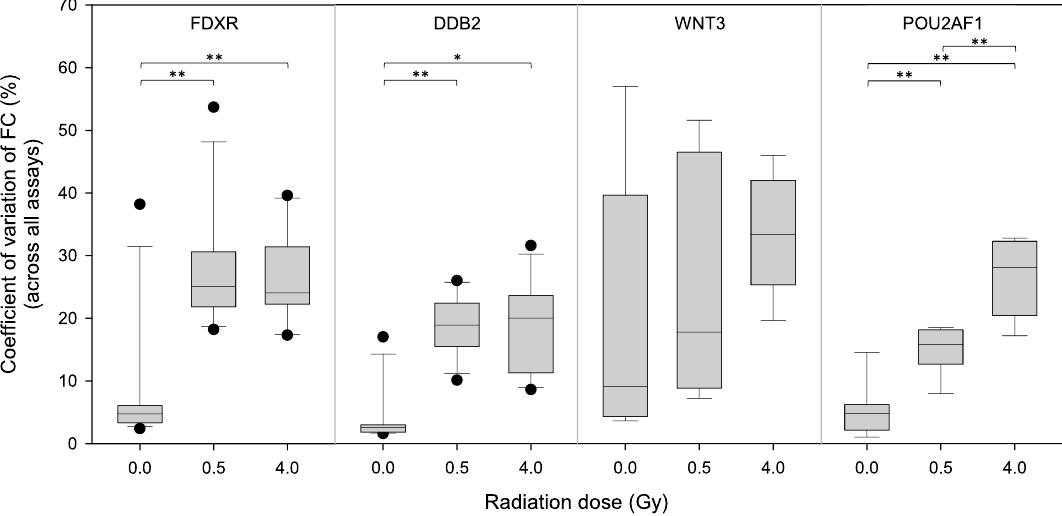
Figure 10. Box plots of coefficient of variations of fold changes of FDXR, DDB2, WNT3, POU2AF1 across all assays per dose category. Horizontal lines within boxplots represent medians. The upper and lower whiskers correspond to 1.5 × of the interquartile range. Black dots represent outliers. p -Values were calculated between exposure groups (0 Gy, 0.5 Gy, 4 Gy) using repeated measurements ANOVA with Tukey’s Test as a post-hoc test and p -values ≤ 0.01 and ≤ 0.001 are marked with one and two asterisks. ANOVA analysis of